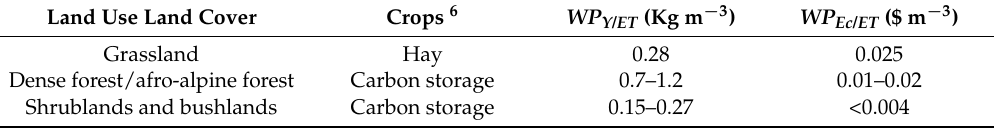
Table 8. Yield and economic water productivity for natural landscapes in the Pangani River